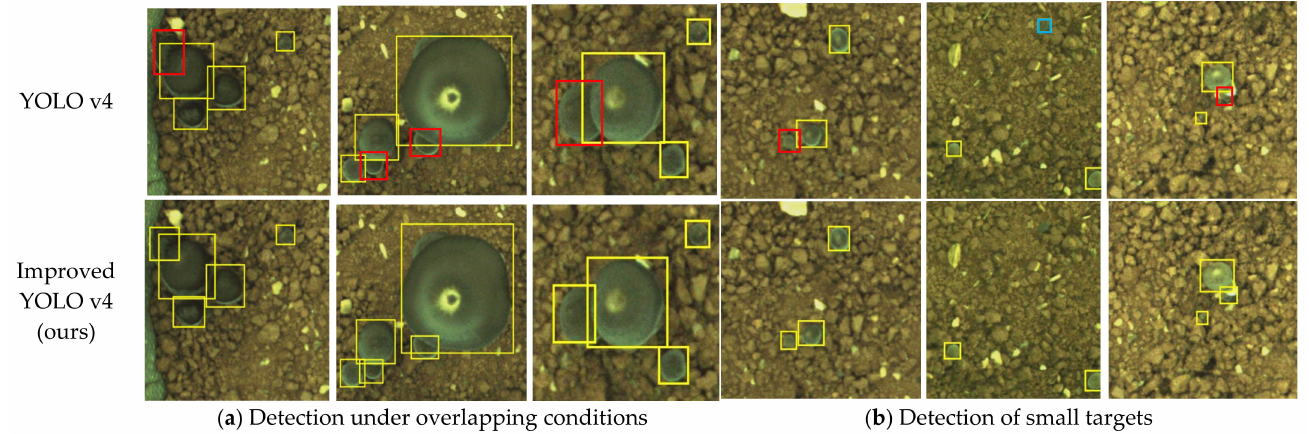
Figure 10. Detection results based on YOLO v4 and the improved YOLO v4 (ours) algorithm.